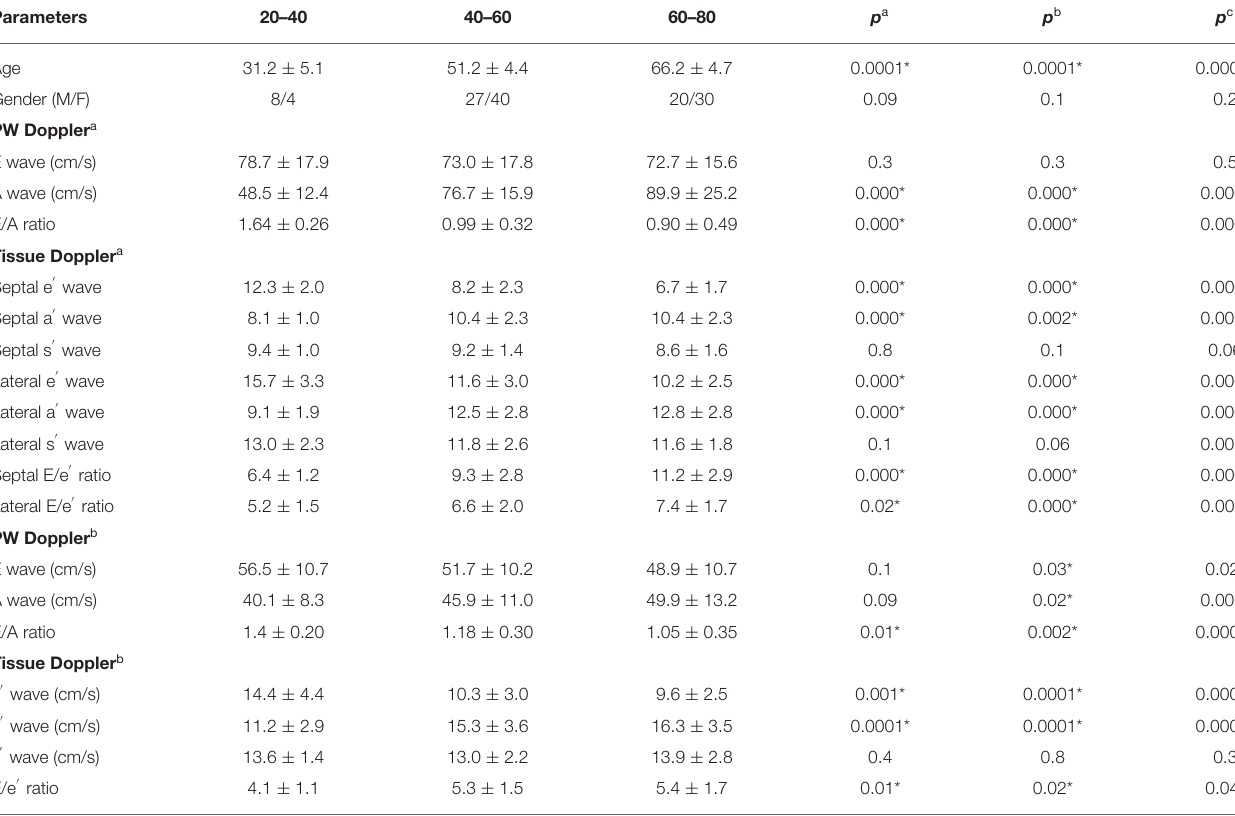
TABLE 2 | The relationship between age and cardiac Doppler parameters in primary varicose vein patients.